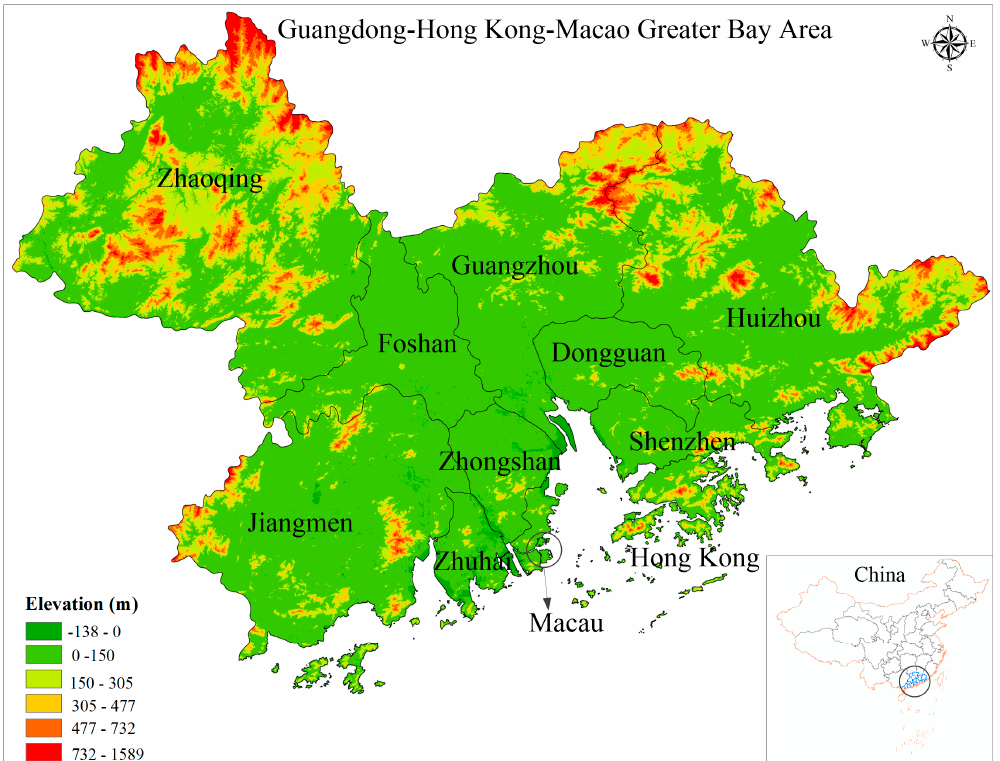
Figure 1. The location of the Guangdong–Hong Kong–Macau Greater Bay Area (GBA) of China.